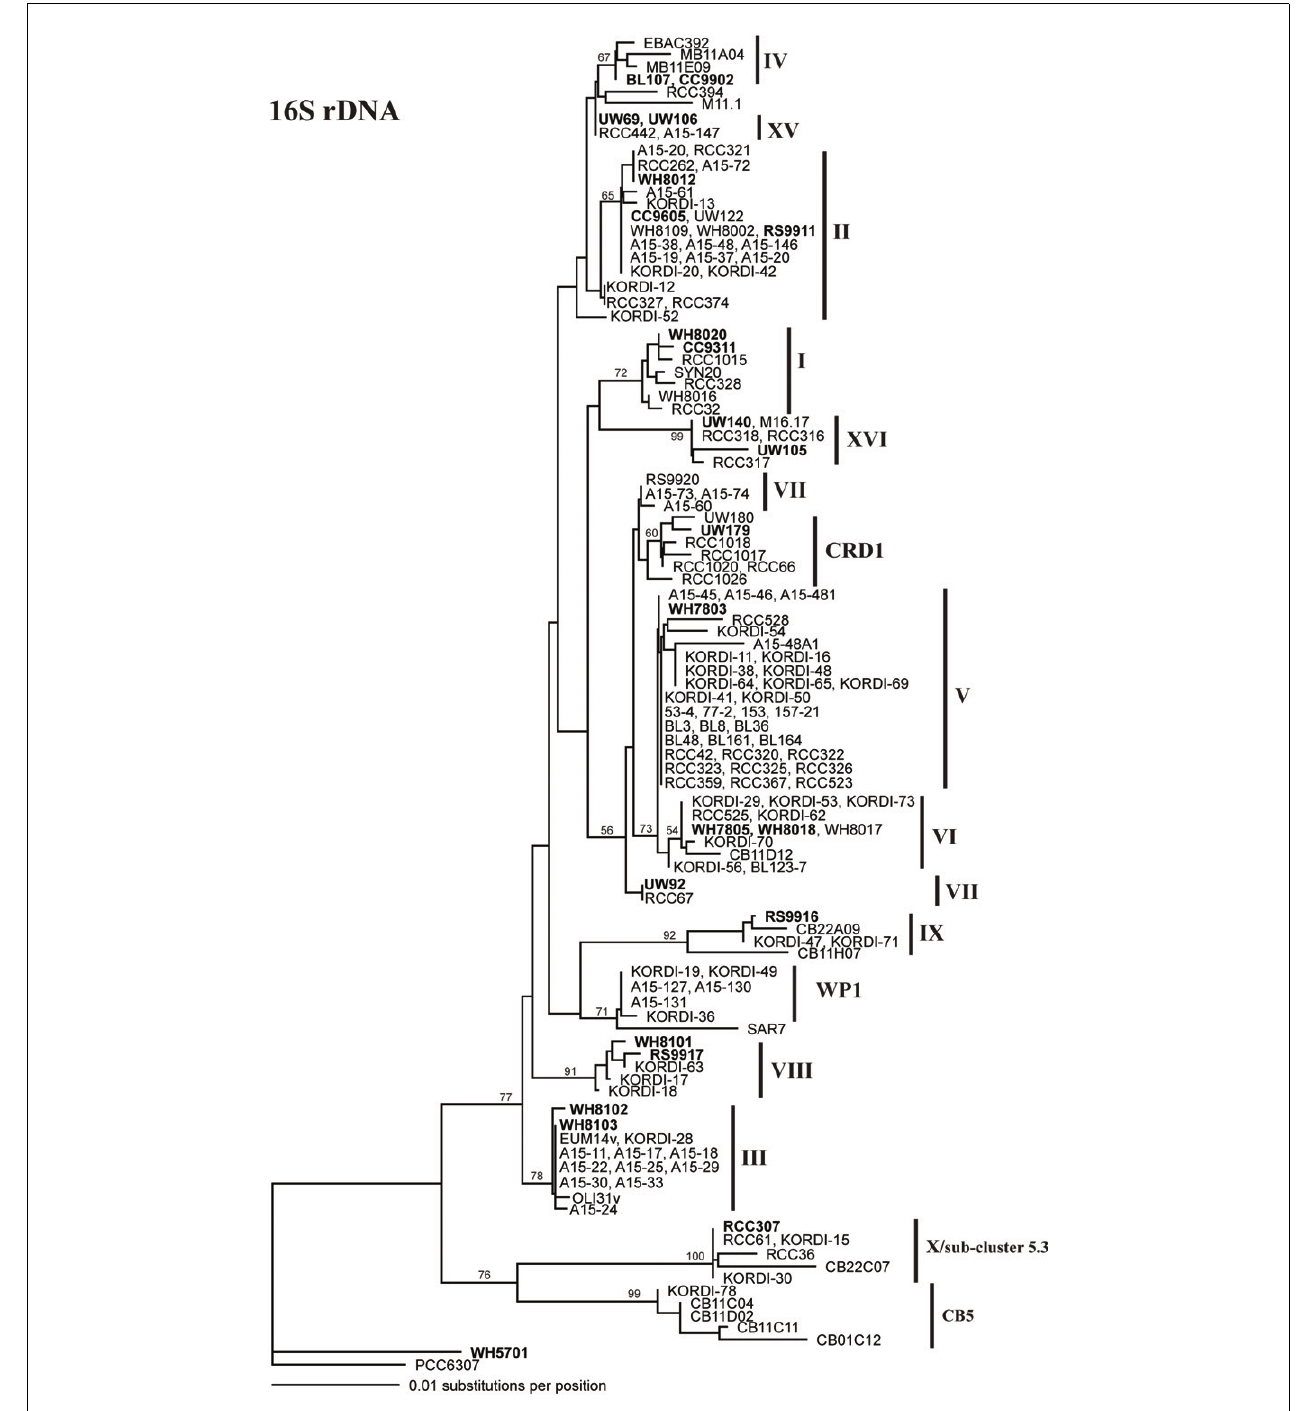
FIGUREA1 | Phylogenetic tree based on 1009 positions of the 16S rDNA gene. The trees were constructed in PAUP using the HKY + i + g model. Values at the nodes indicate the bootstrap support from 1000 trees found by